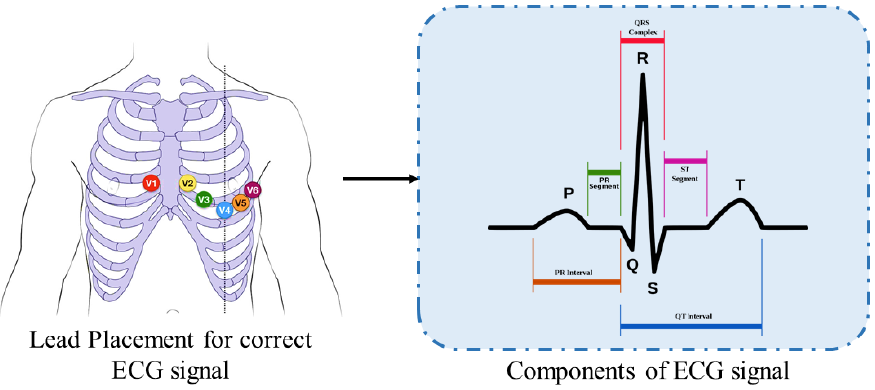
Figure 1. ECG lead placement with components of ECG beat.